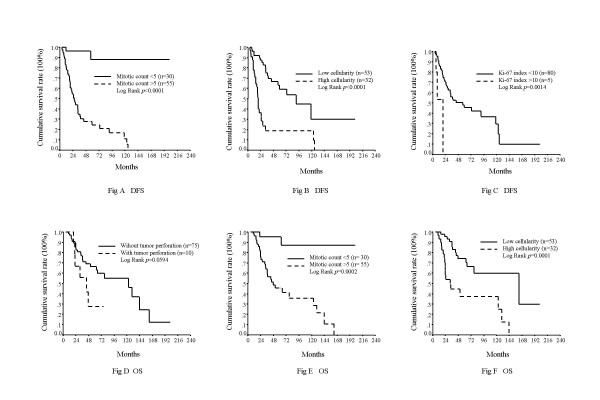
Disease-free survival for 85 patients with small bowel gastrointestinal stromal tumor (GIST) who underwent curative resection in terms of (A) mitotic count; (B) tumor cellularity; (C) Ki-67 index; and overall survival for 85 patients with small bowel GIST who underwent curative resection in terms of (D) tumor perforation; (E) mitotic count; (F) cellularity.